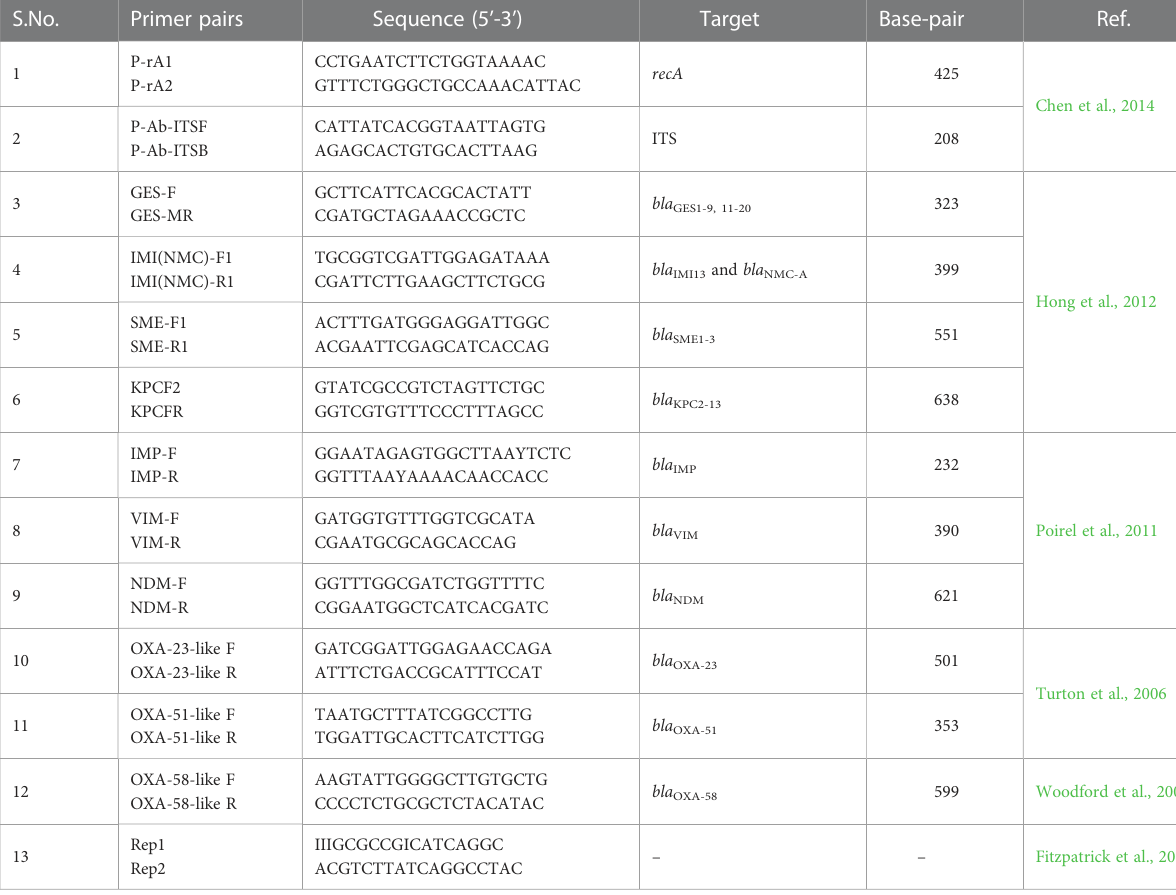
TABLE 1 Primer sequences used in the study.